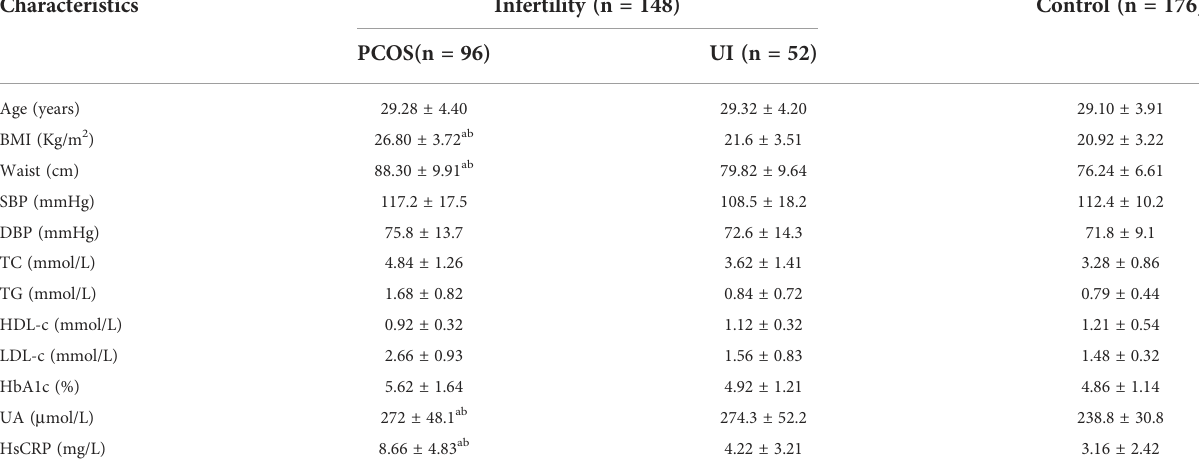
TABLE 1 Clinical characteristics of the studied